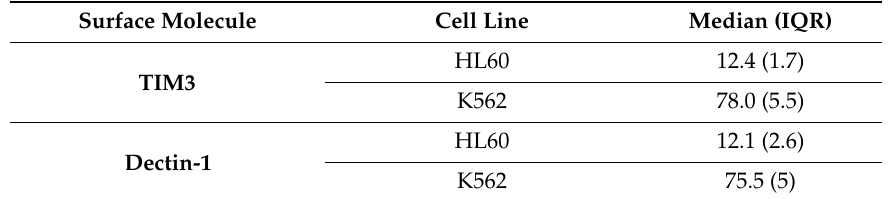
Table 3. Cytofluorimeter assay on HL-60 and K-562 cell lines. Percentages of cells expressing TIM3 and Dectin-1 are reported as median and interquartile range (IQR) calculated for three